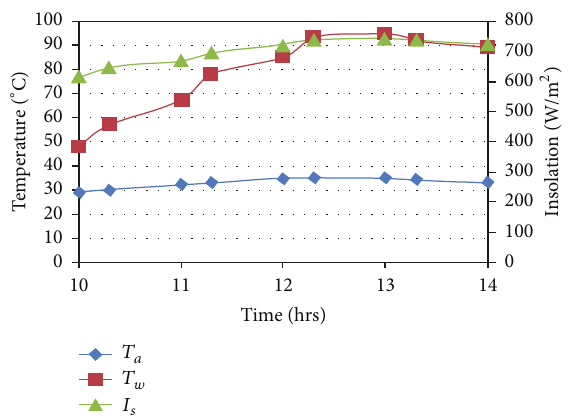
Figure 4: Water heat up test of solar cooker for second figure of merit ( 𝐹 2 ) (07/03/2013).